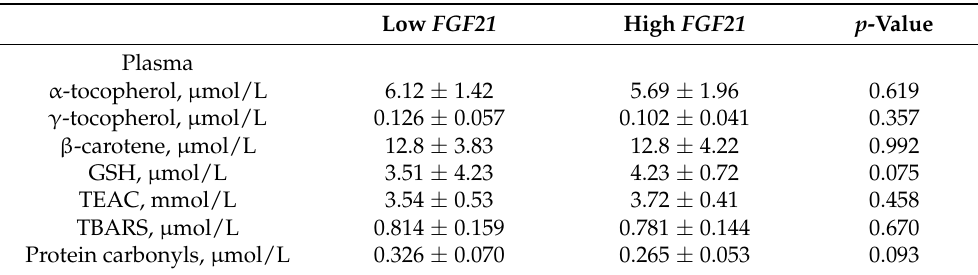
Table 5. Plasma concentrations of parameters indicative of antioxidant status in cows with high and low hepatic FGF21 expression at week 1 postpartum.